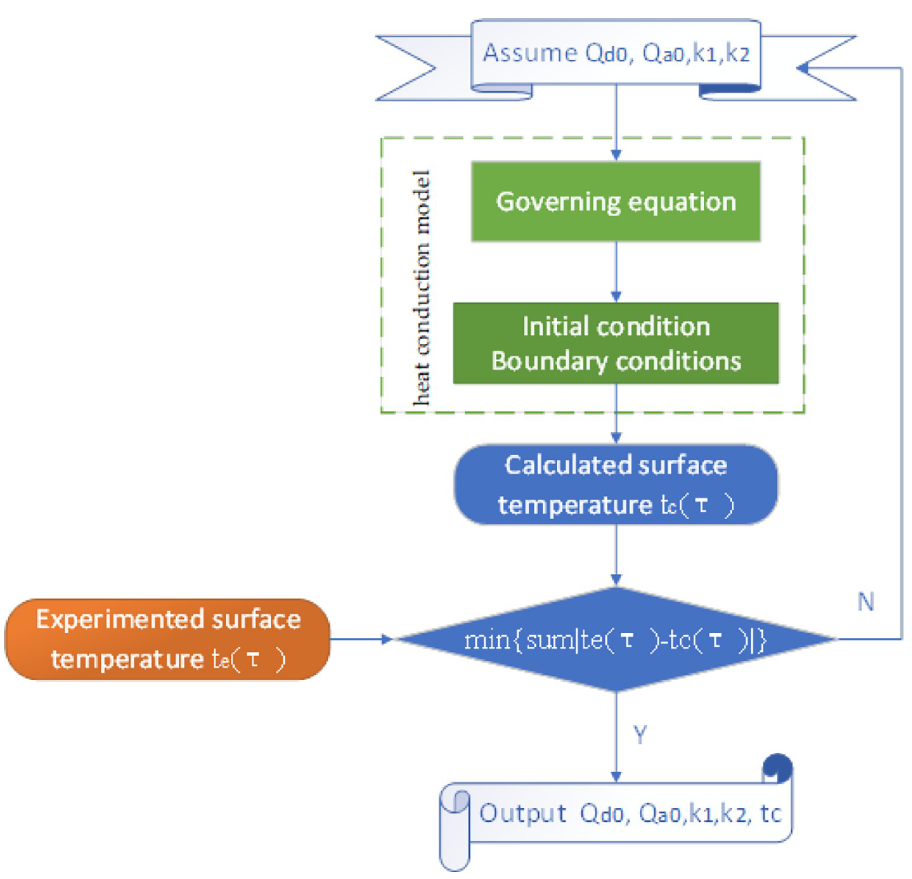
Fig 4. Flow chart of the least-square optimization calculation